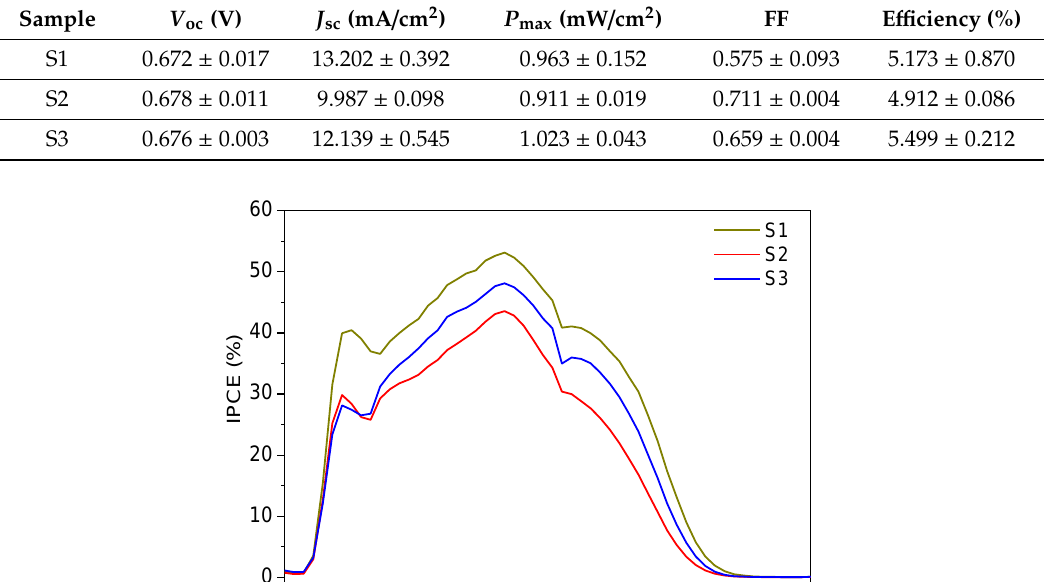
Figure 5. Incident Photon-to-Current Conversion Efficiency (IPCE) spectra for DSSCs fabricated using S1, S2, and S3 samples.